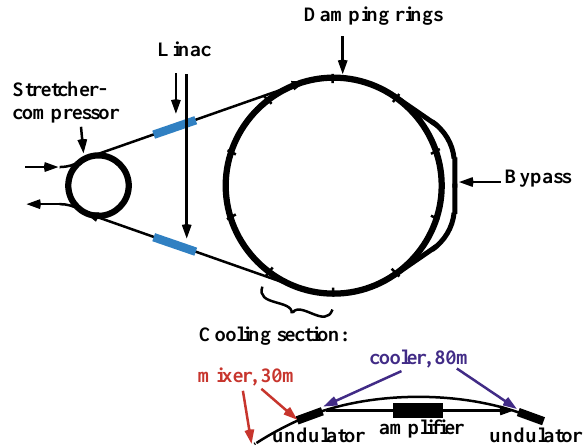
FIG. 3. (Color) The cooling